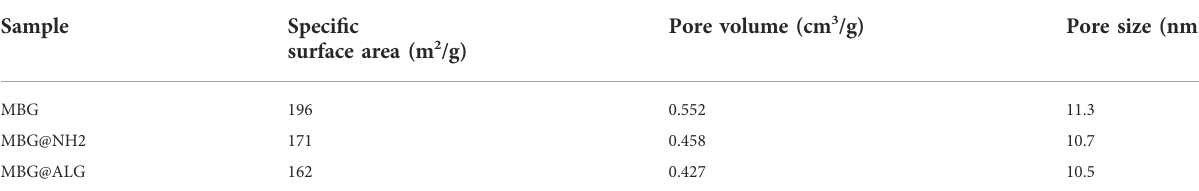
TABLE 1 Summary of the including speci fi c surface area, pore volume, and pore size as determined from N 2 adsorption – desorption isotherms.